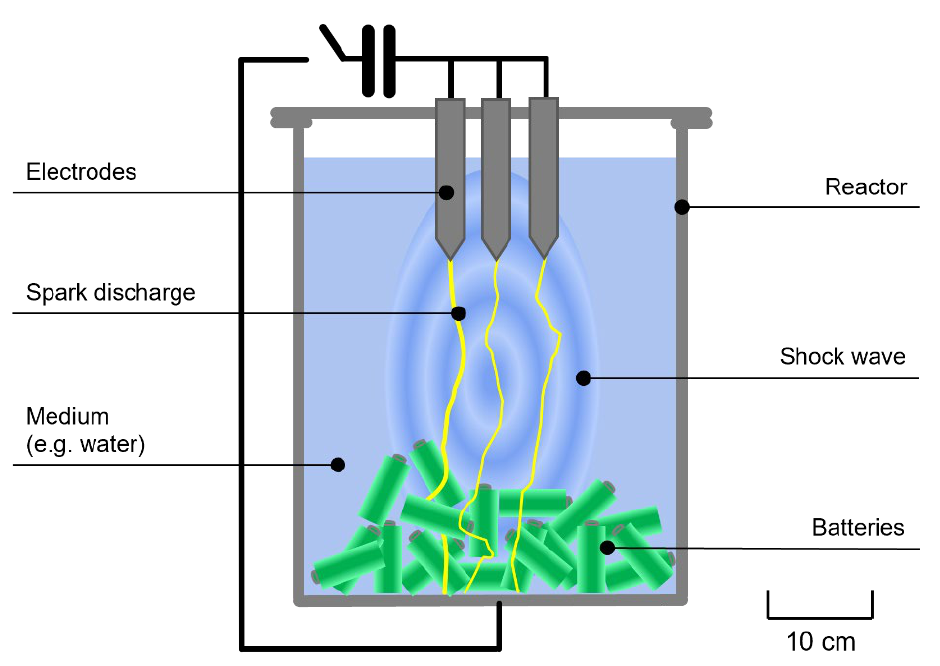
Figure 2. Schematic functional principle of electrohydraulic fragmentation.